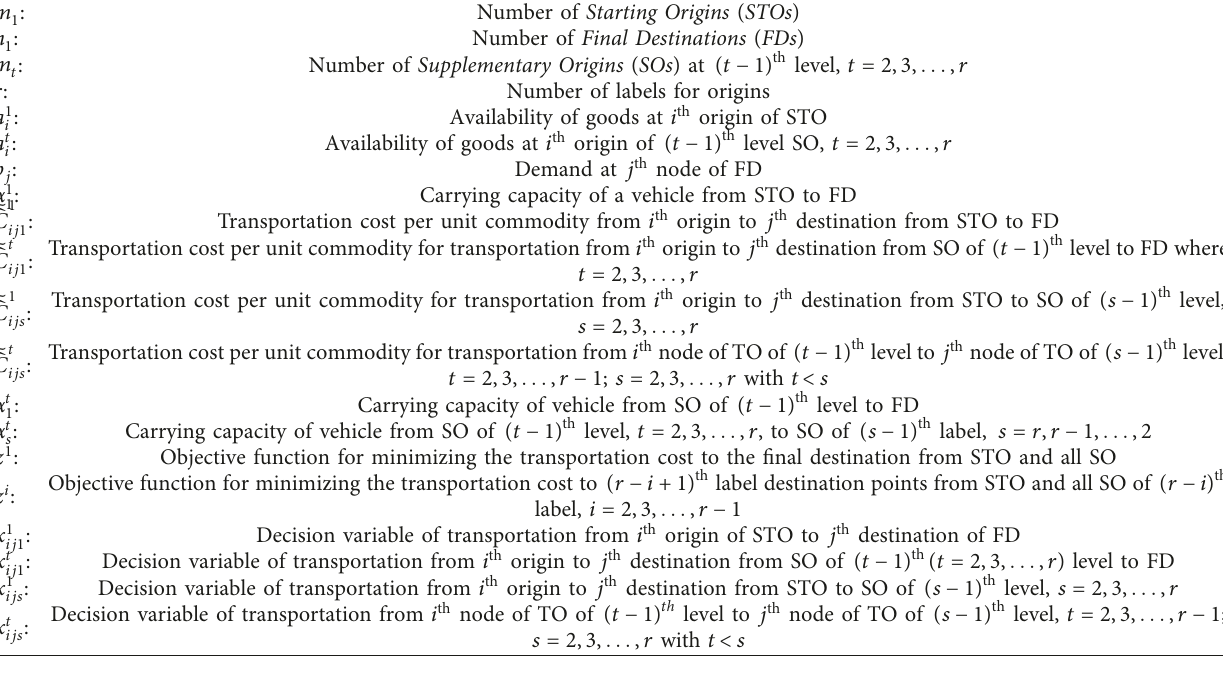
Table 2: Different notations for designed mathematical